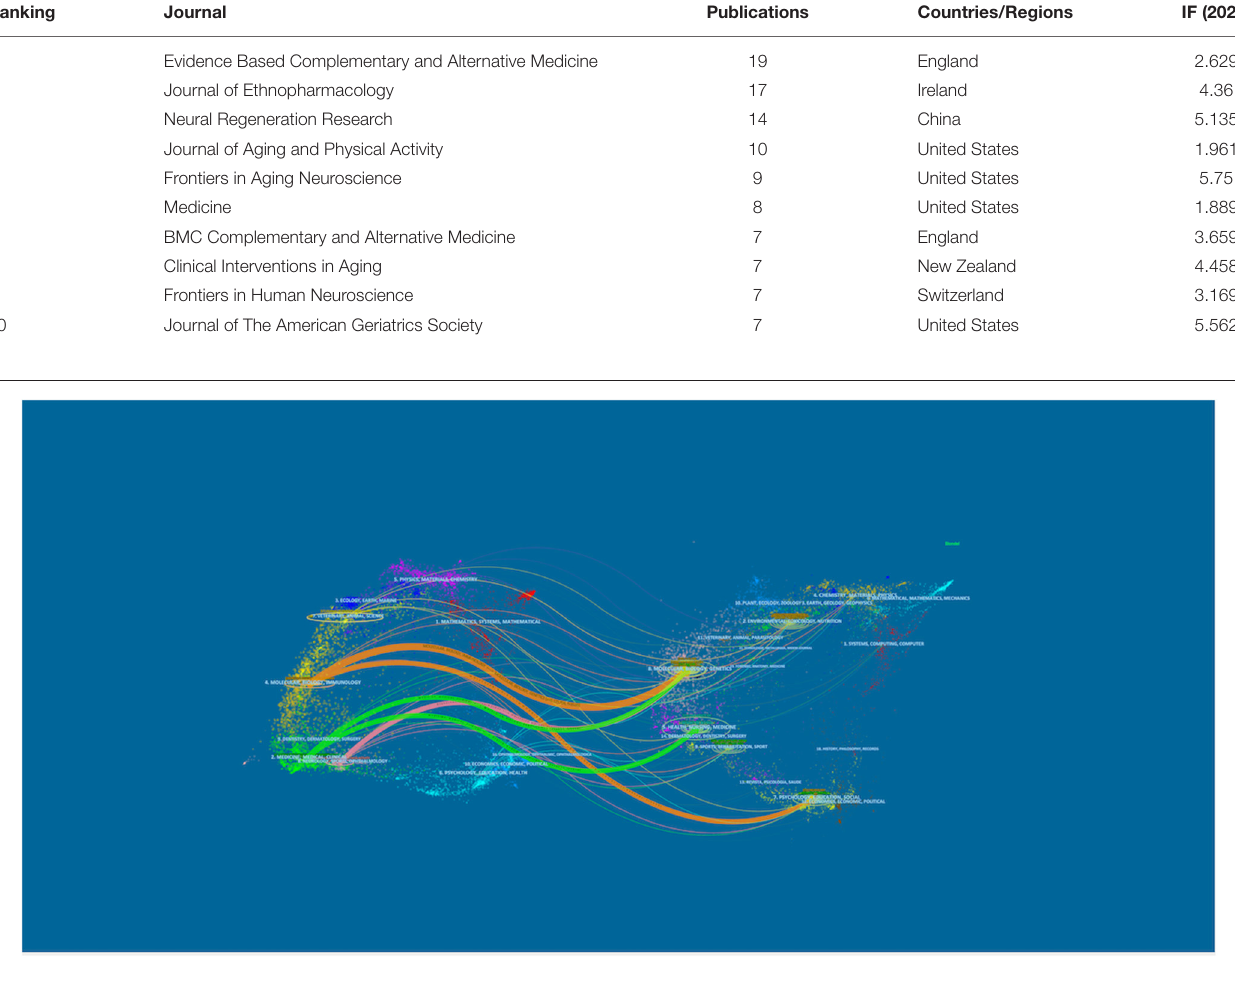
FIGURE 4 | Dual-map overlay of academic journals from 2001 to 2020. centrality, “Alzheimer’s disease,” “exercise,” “dementia,” “older adult,” “cognitive function,” and “quality of life” were the